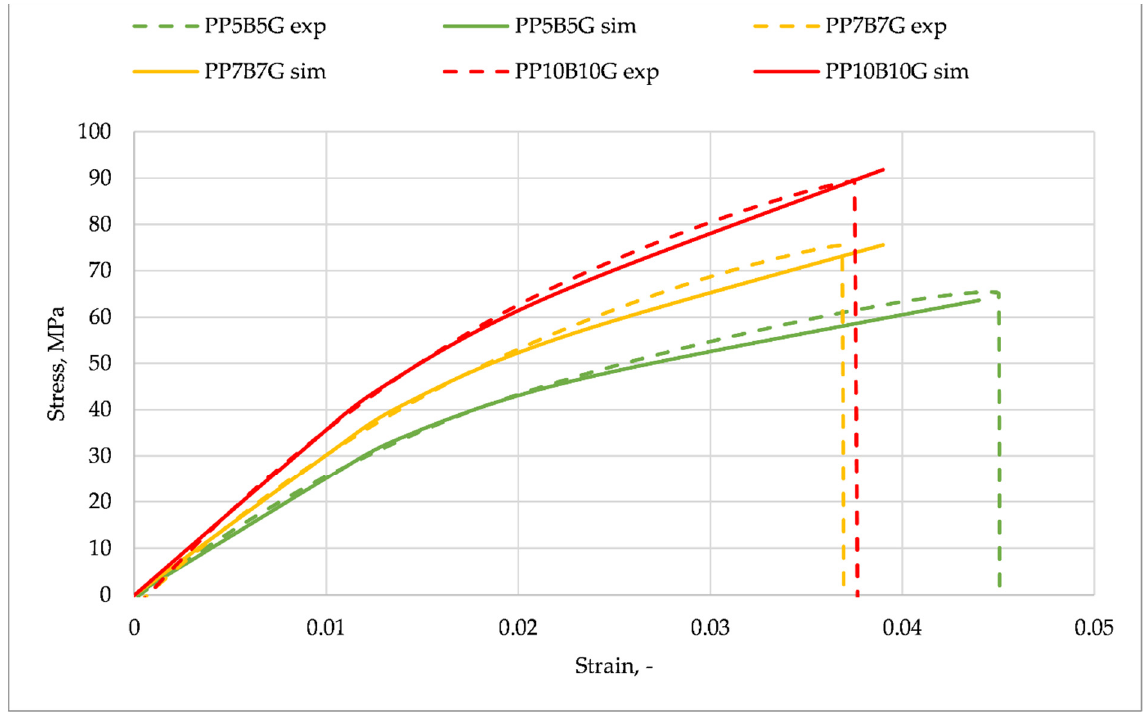
Figure 4. Stress–strain curves. Results of Digimat material analysis compared to measured data.